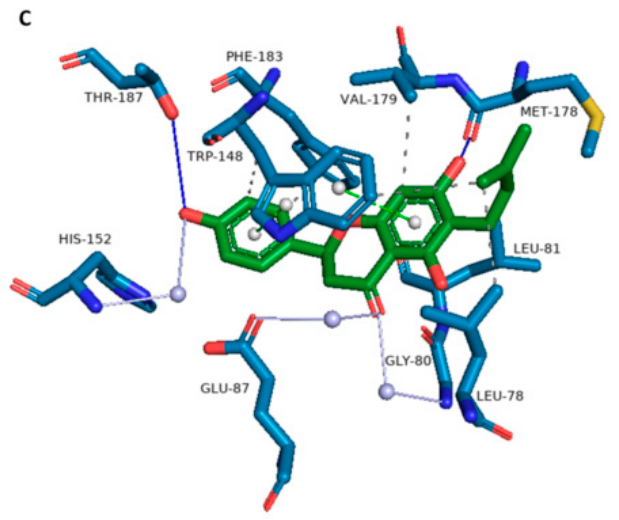
Figure 6. Analysis of interactions between the binding site of acyl-protein thioesterase 2 (blue) and ( A ) xanthohumol (gray), ( B ) isoxanthohumol (purple), and ( C ) 6-prenylnaringenin (green). Hydrogen bonds are represented by blue lines, water bridges by light purple, π -stacking by green, and hydrophobic interactions by gray.